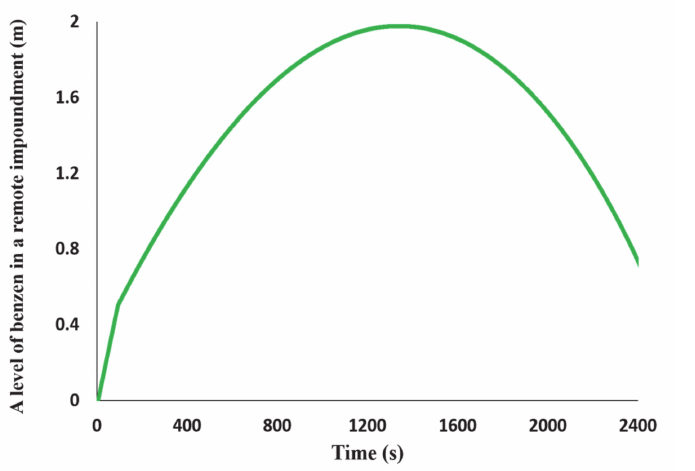
Figure 8. The level of the benzene in the remote impoundment. This result shows that Pump 2 can prevent the overflow of the remote